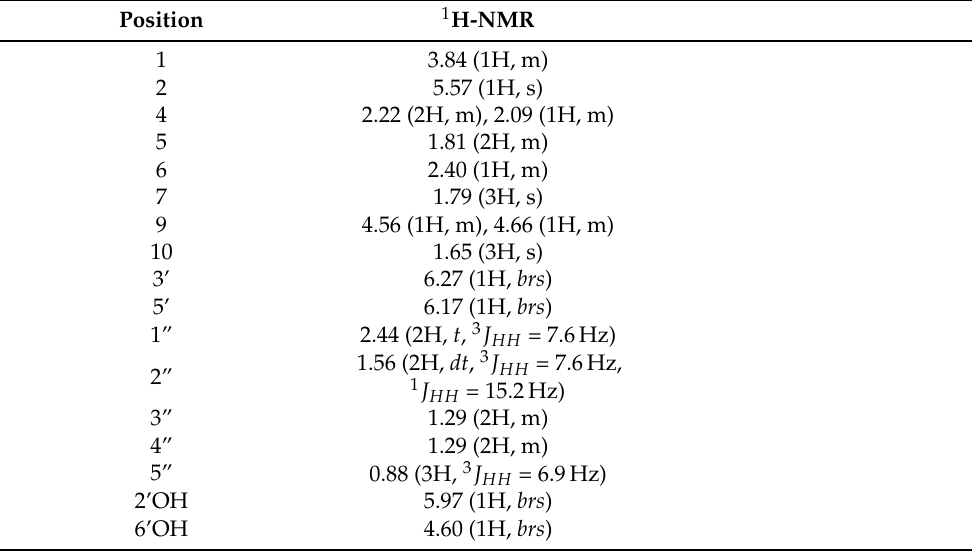
Figure A1. 1 H-NMR spectrum of the CBD sample, which was obtained and used for the loading and release experiments. The measurement was performed in CDCl 3 . Table A1. 1 H-NMR assignments for cannabidiol measured in CDCl 3 at